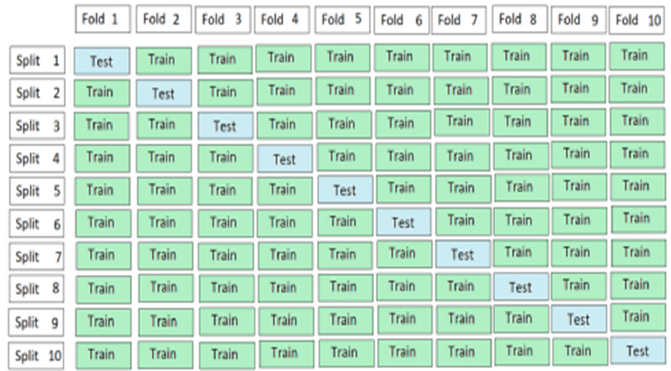
Figure 6. Working process of 10-fold cross-validation.